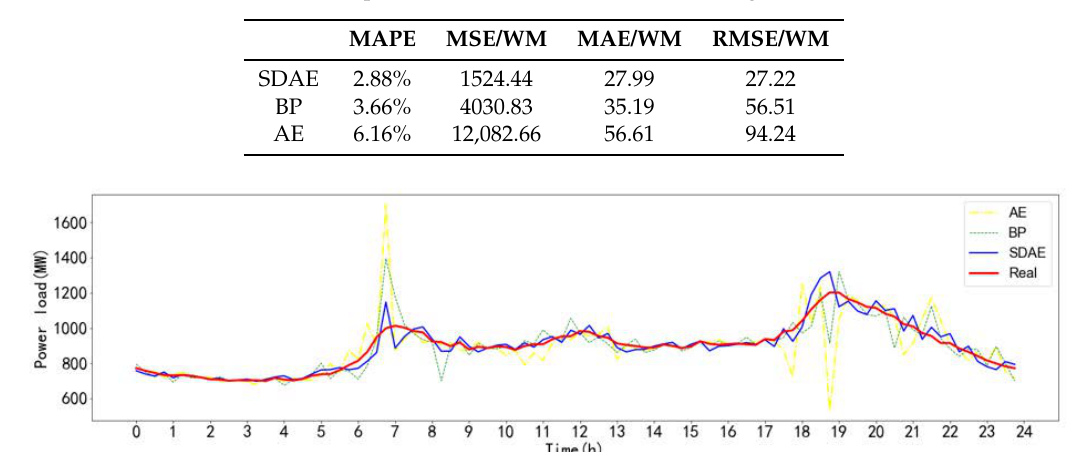
Table 3. Comparison of errors of different forecasting methods.